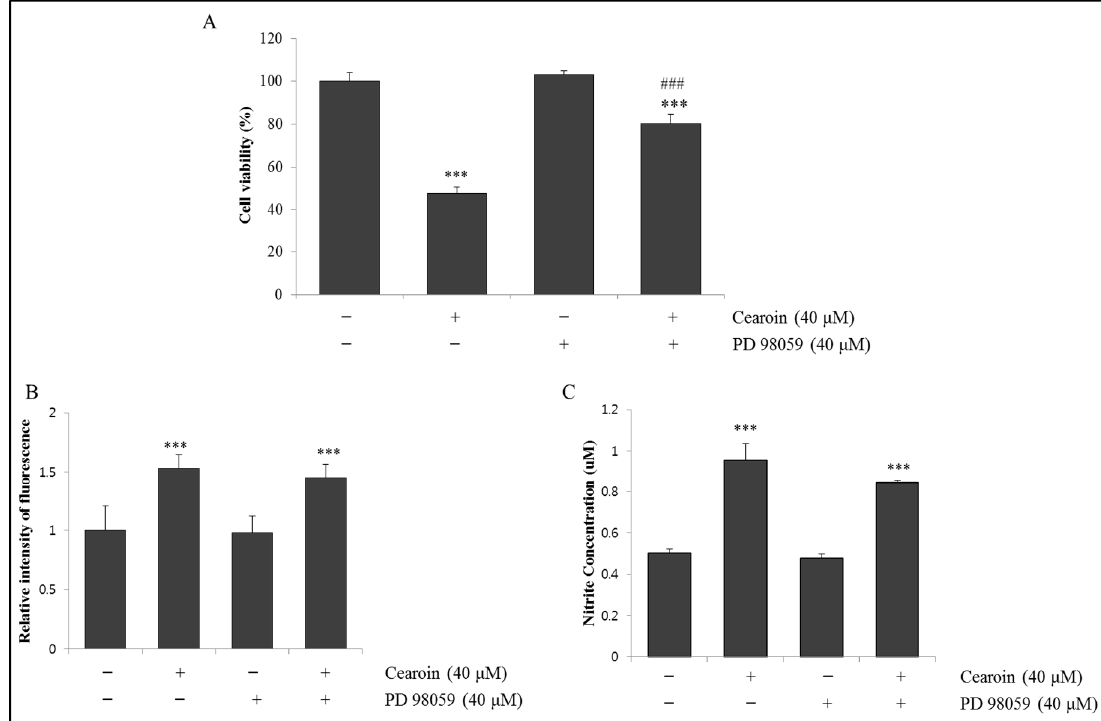
Figure 6. PD98059 partially reverses the cearoin-induced cell death in neuroblastoma SH-SY5Y cells. SH-SY5Y cells were pre-incubated with or without MEK inhibitor PD98059 (40 μ M) for 1 h and then treated with or without cearion (40 μ M) and incubated for a further 12 h. ( A ) Cell viability was measured using MTT assay; ( B , C ) ROS and NO levels were measured using DCFDA fluorescence method and Griess reagent respectively. Each bar represents the mean percentage alterations above or below the control (±SD) ( n = 6). Differences were considered statistically significant at *** p < 0.001 as compared with the control, ### p < 0.001 as compared with the 40 μ M cearoin treated group.